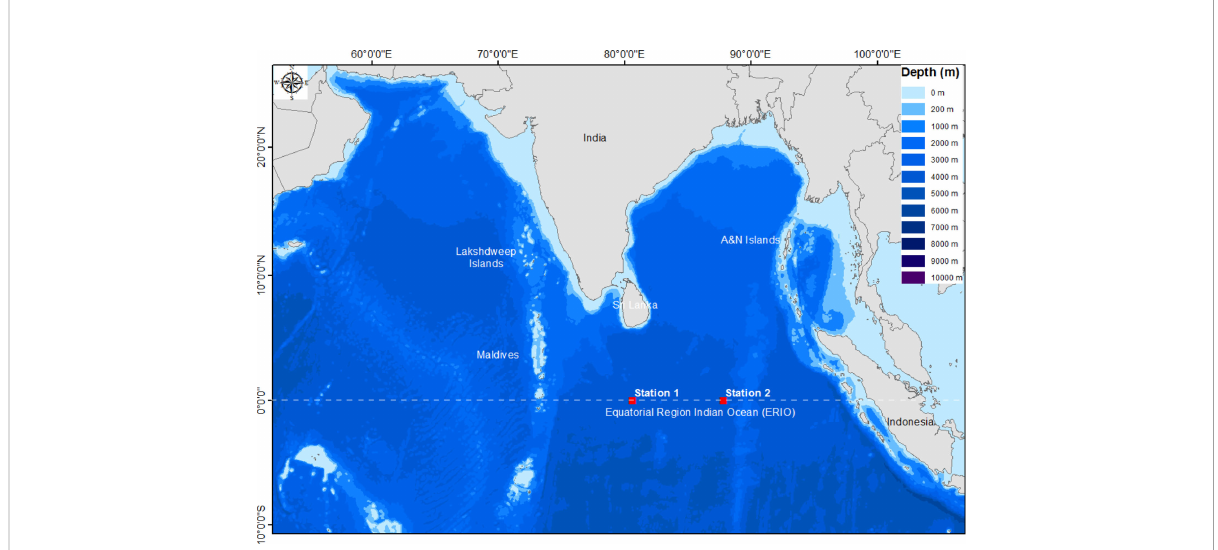
FIGURE 1 Study area map showing selected sites of ERIO for sample collection. The map was prepared using the Arc GIS software (Version